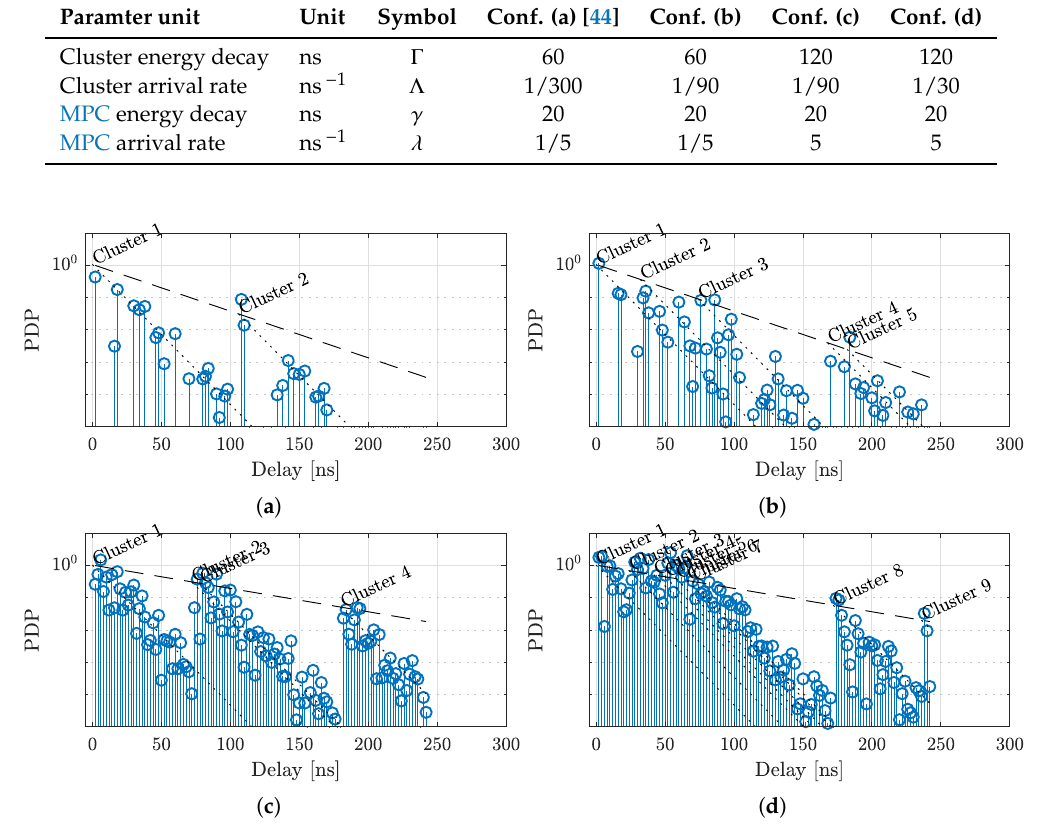
Figure 3. Sample Saleh–Valenzuela PDPs. The plots show a realization for Conf. ( a–d ), each produced with the same random seed. The four configurations have progressively dense intra-cluster